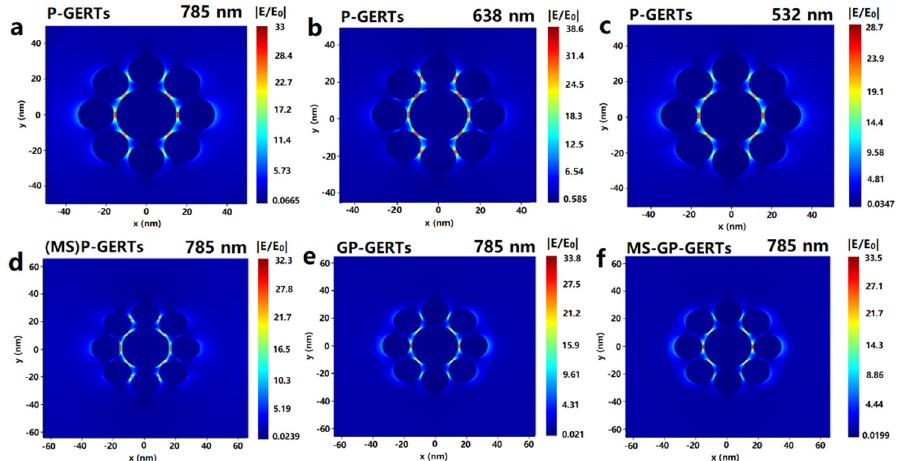
Figure 7. ( a – c ) Electric field enhancement distributions of single P-GERTs calculated by FDTD at excitation wavelengths of 785, 638, and 532 nm; ( d – f ) Electric field enhancement distributions of single (MS)P-GERTs, GP-GERTs, and MS-GP-GERTs, all with excitation wavelengths of 785 nm.